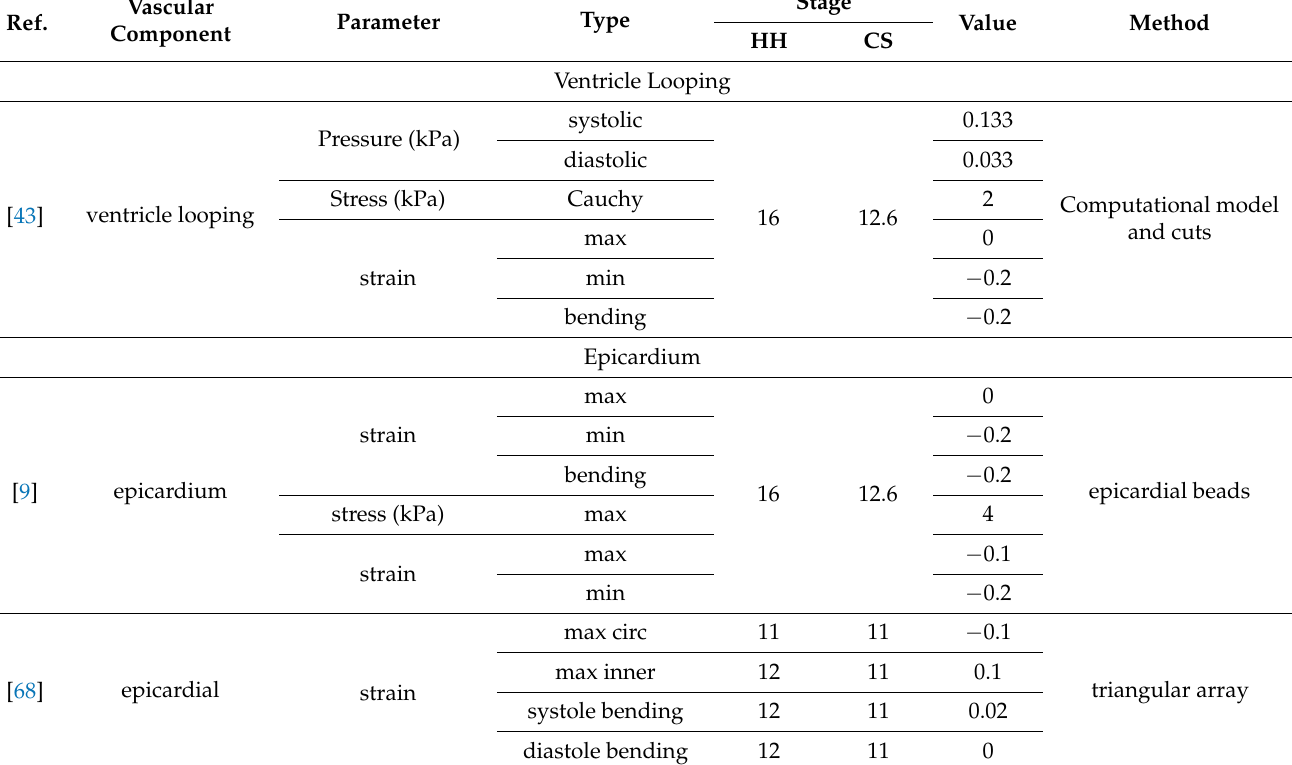
Table 2. Material properties of embryonic ventricles are summarized for the avian embryo. Regional properties of ventricles, epicardium, valve leaflets/cushions, atrioventricular region, myocardial wall, dorsal aorta, and atrium are compiled as available in the literature. Properties were evaluated at different embryonic stages primarily using the methods in Table 1. Reference sources (Ref.) are provided in the first column. LV: left ventricle, MPA: micropipette aspiration, RV: right ventricle, CTB: conotruncal banding, LAL: left-atrial ligation, FEM: finite element modeling, AV: atrioventricular, CS: Carnegie